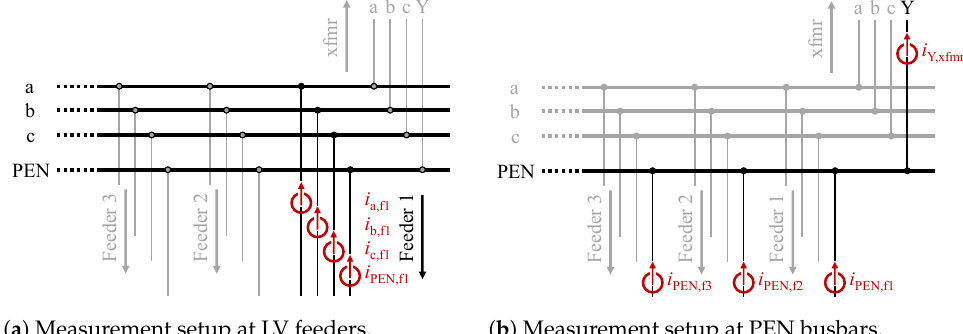
( b ) Measurement setup at PEN busbars.